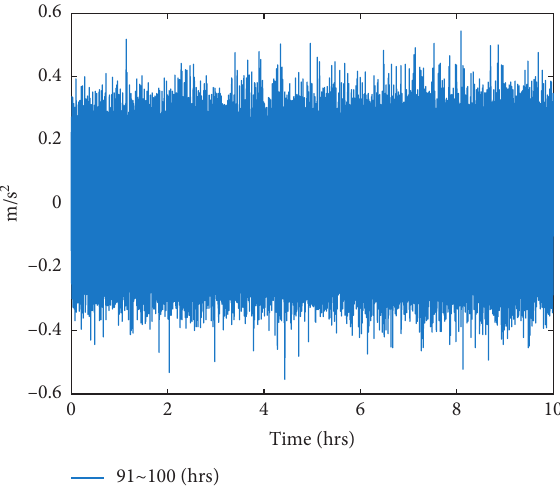
Figure 8: Vibration signals of abnormal bearing.